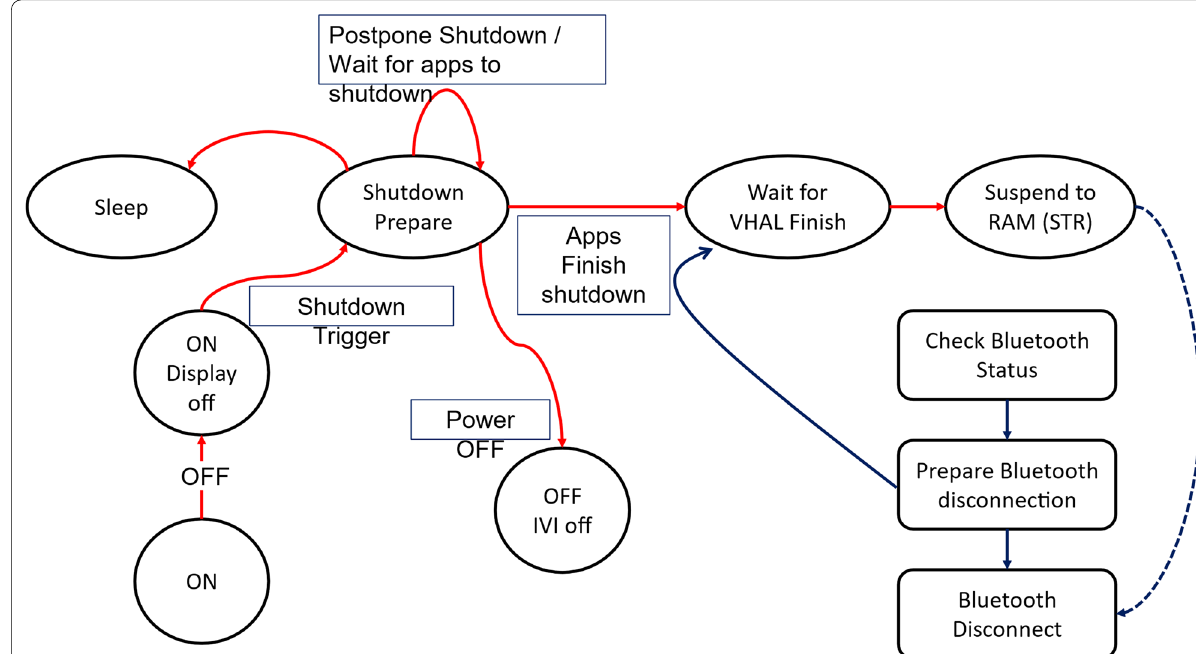
Fig. 9 Proposed state machine to mitigate the attack—clear the stored memory upon Bluetooth disconnection. The Suspend to RAM (STR) and Bluetooth Disconnection, shown by the dotted line, is a synchronized process, not an edge